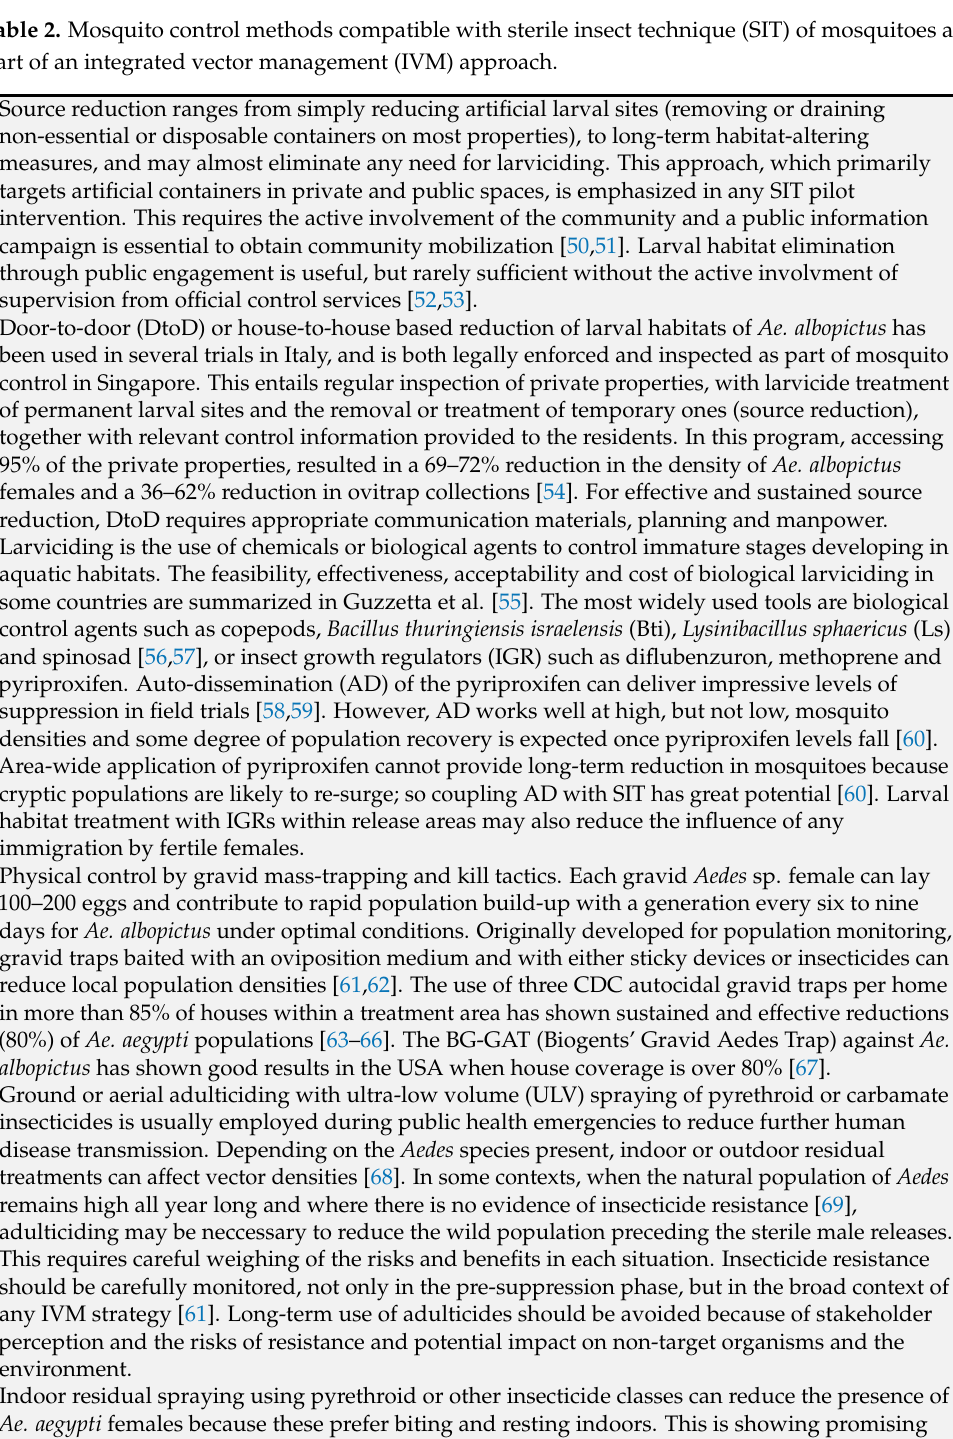
Table 2. Mosquito control methods compatible with sterile insect technique (SIT) of mosquitoes